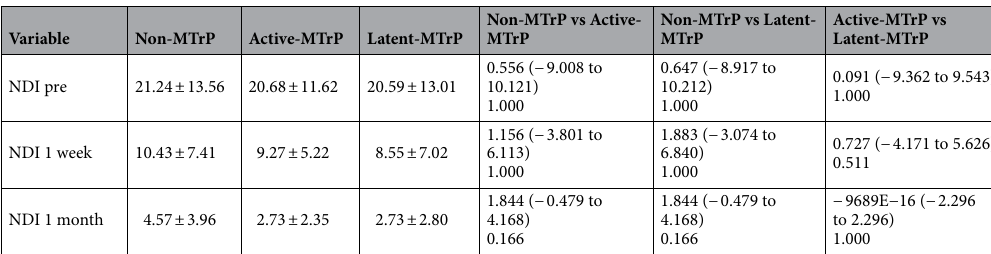
Table 6. Neck Disability Index. Comparison between groups. Comparison between groups: Difference of means, Confidence interval and P value according to Bonferroni’s correction. *Indicates statistical significance P < 0.05.